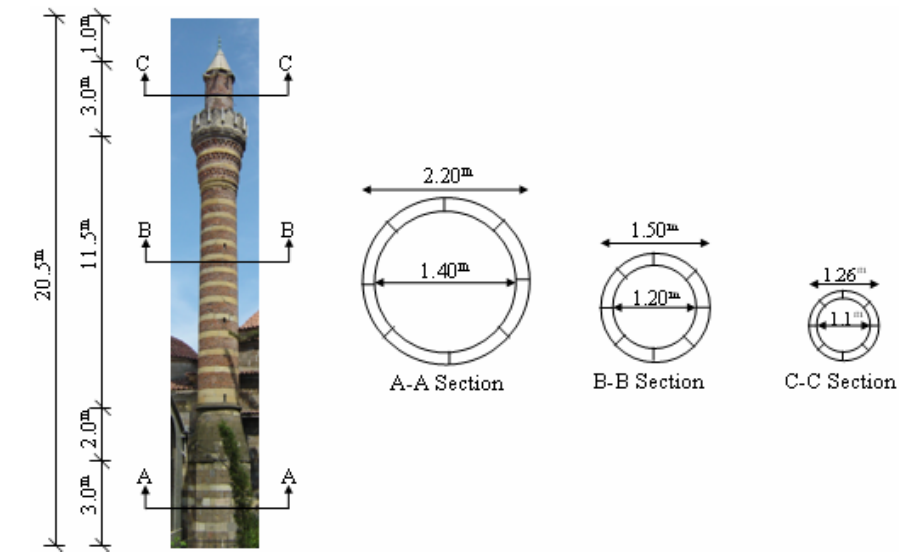
Fig. 3. Geometrical properties of the